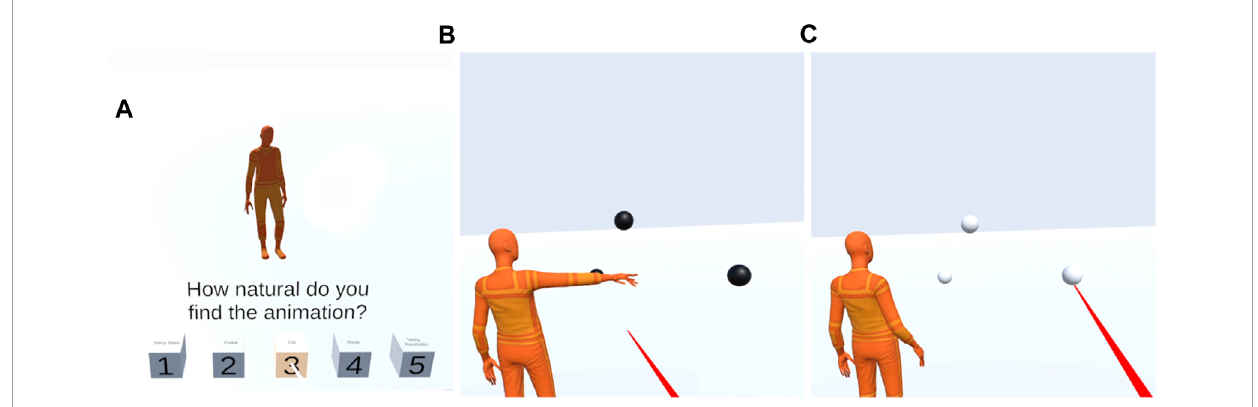
FIGURE 6 Examples of user view in the VR based perceptual test. Stage 1 shown in (A) : the user rates the naturalness of the pointing gesture. Stage 2 shown in (B, C) : the virtual agent first makes a pointing gesture in the presence of the actual pointing target and two distractor objects (B) , the user then guesses the pointed object (referential game) with the raycast selection mechanism (C) .